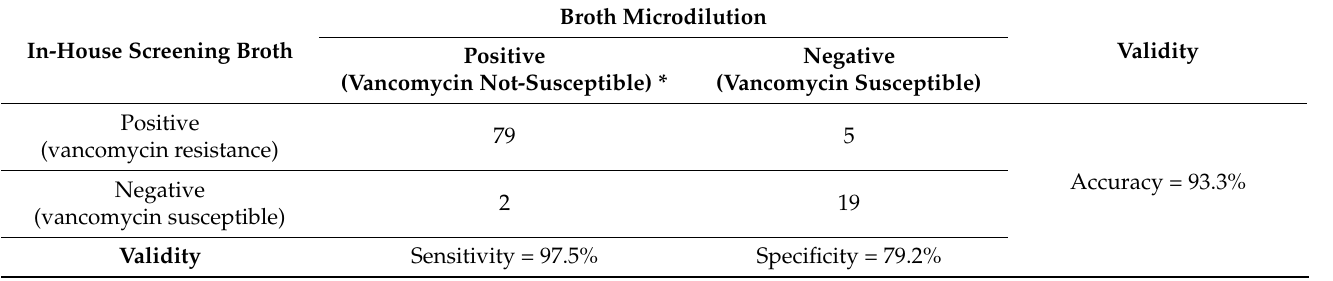
Table 2. Validity of in-house VREfm screening broth to determine vancomycin resistance compared with broth